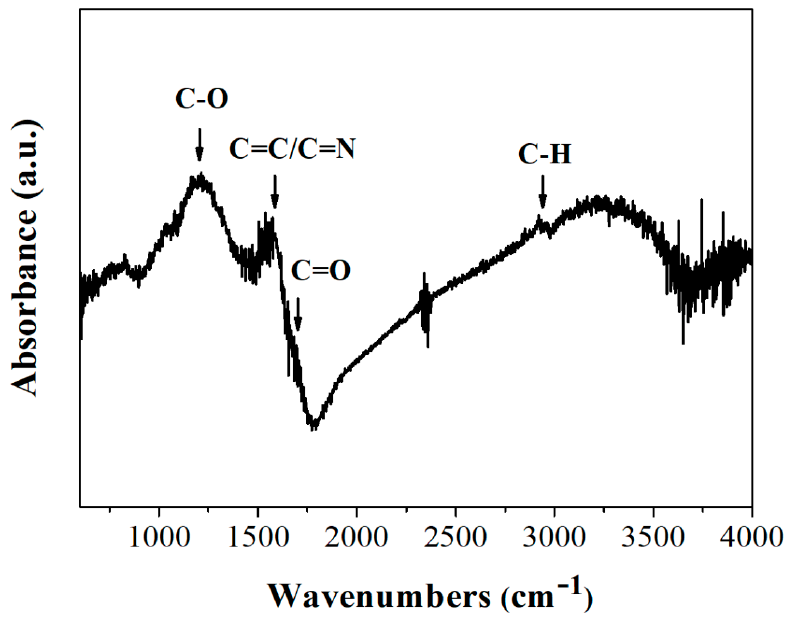
Figure 4. ATR infrared spectrum of the carbon solid.